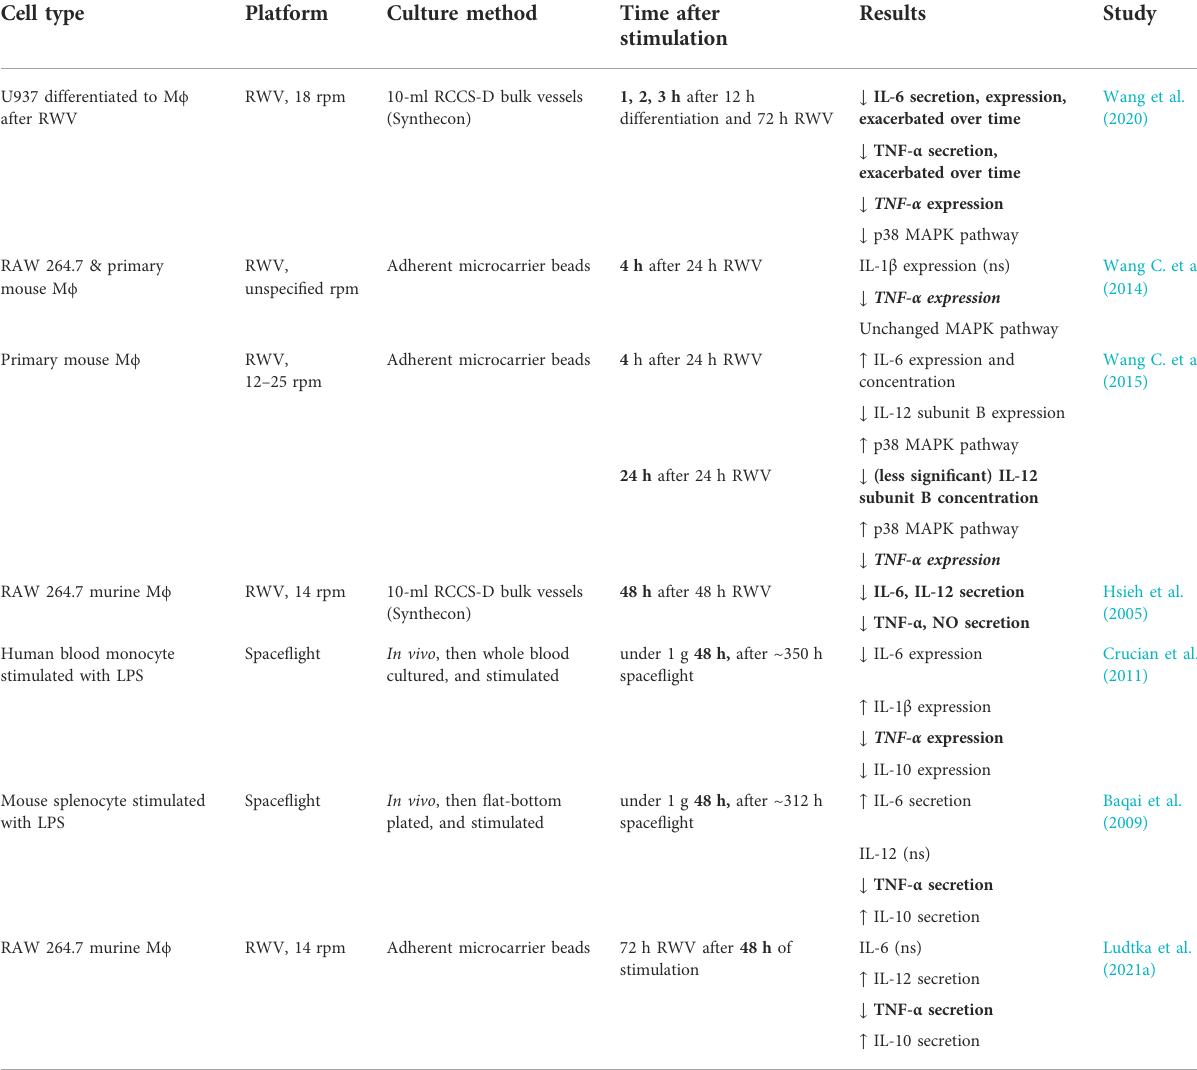
TABLE 2 After M ϕ stimulation, cytokine responses are altered under microgravity over time. Boldened results indicate a reduction in pro- in fl ammatory cytokines TNF- α /IL-6/IL-12/IL-1 β , and thus concordance with our theory of microgravity-based MRTF inhibition. Anti- in fl ammatory cytokines include IL-10. Protocols between studies varied the order between pro-in fl ammatory stimulation and